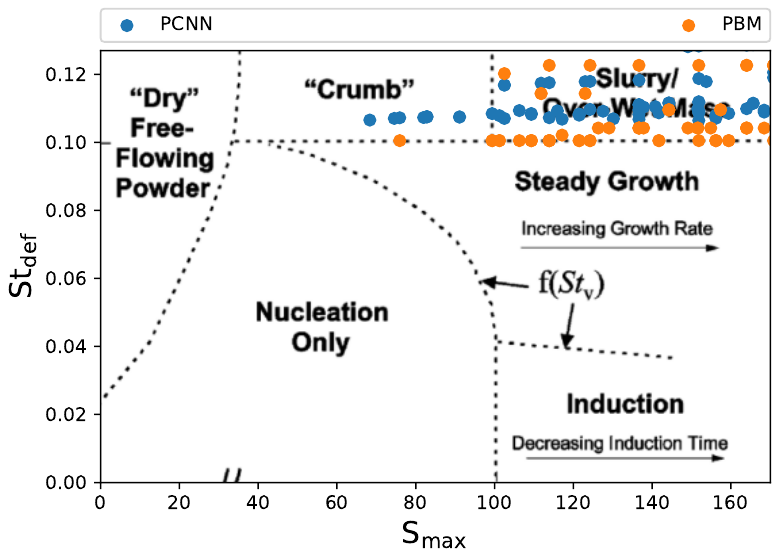
Figure A1. Comparing the PCNN predictions with PBM data with St def > 0.1 and it can be observed that the PCNN is more accurate in identifying the undesired granule growth